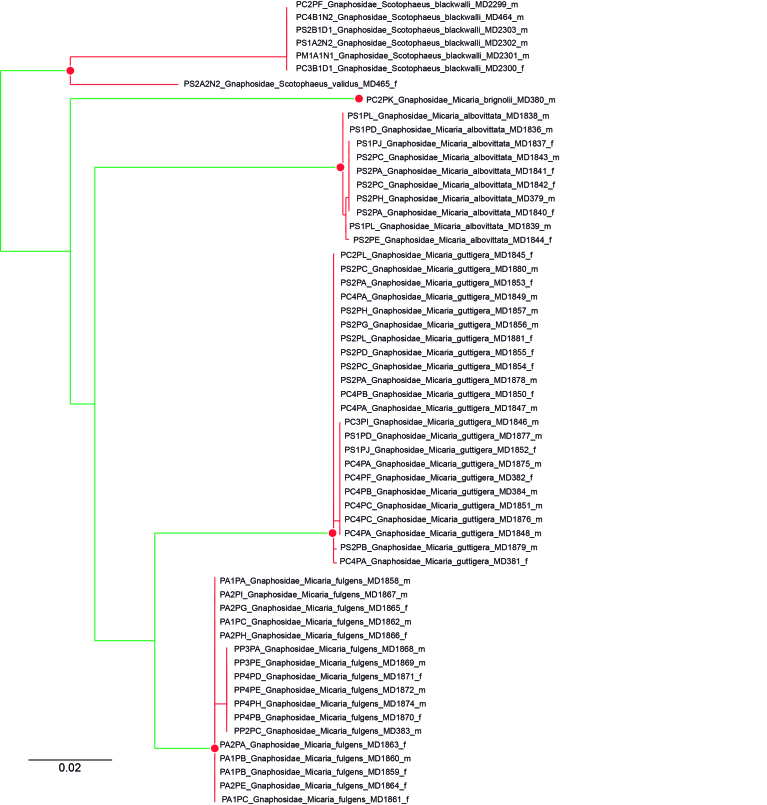
Maximum likelihood tree of the Gnaphosidae DNA barcode sequences analysed, using a codon partition model with IQ-tree. Red coloured clusters correspond to candidate species as delimited using the mPTP algorithm (see text for details).